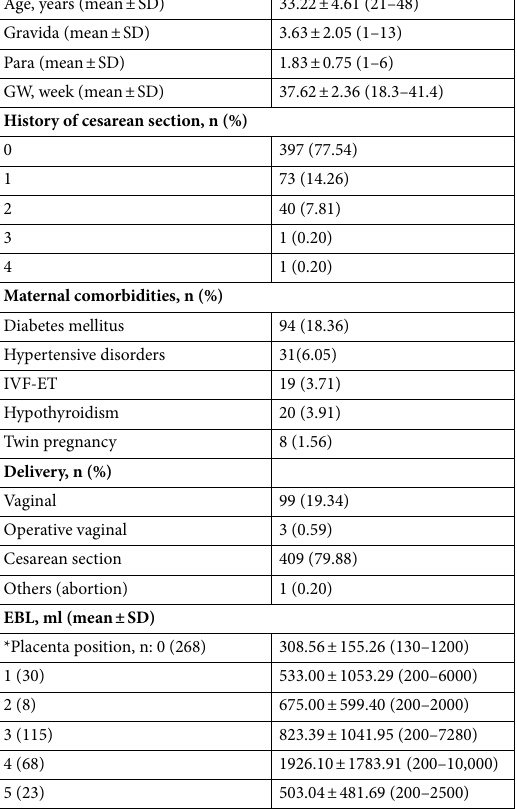
Table 1. Baseline characteristics of the included 512 pregnancies of clinically suspected PAS disorders. EBL, estimated blood loss; IVF-ET, in-vitro fertilization embryo transplantation.